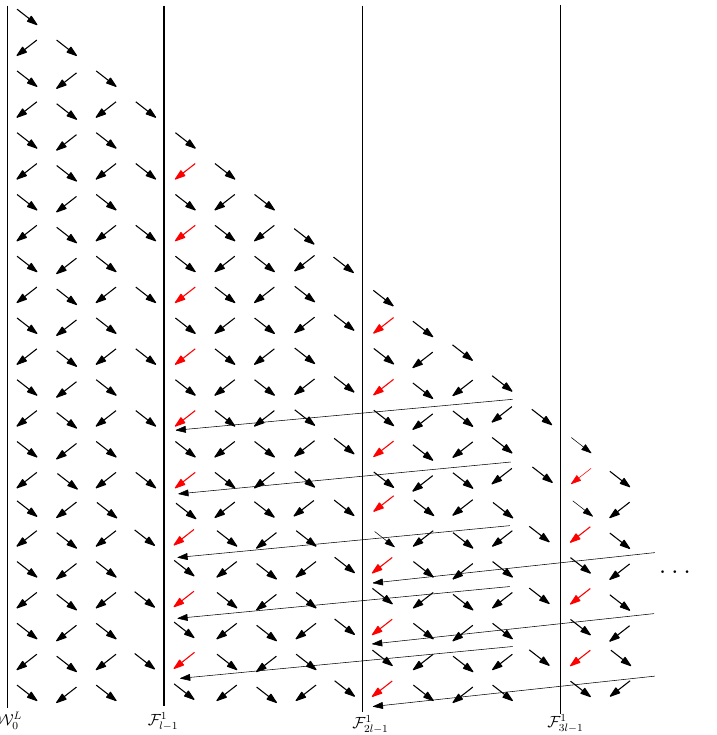
Figure 11. Arrangement of steps for points of the lattice path model L U . Here, we depict the case, where l =